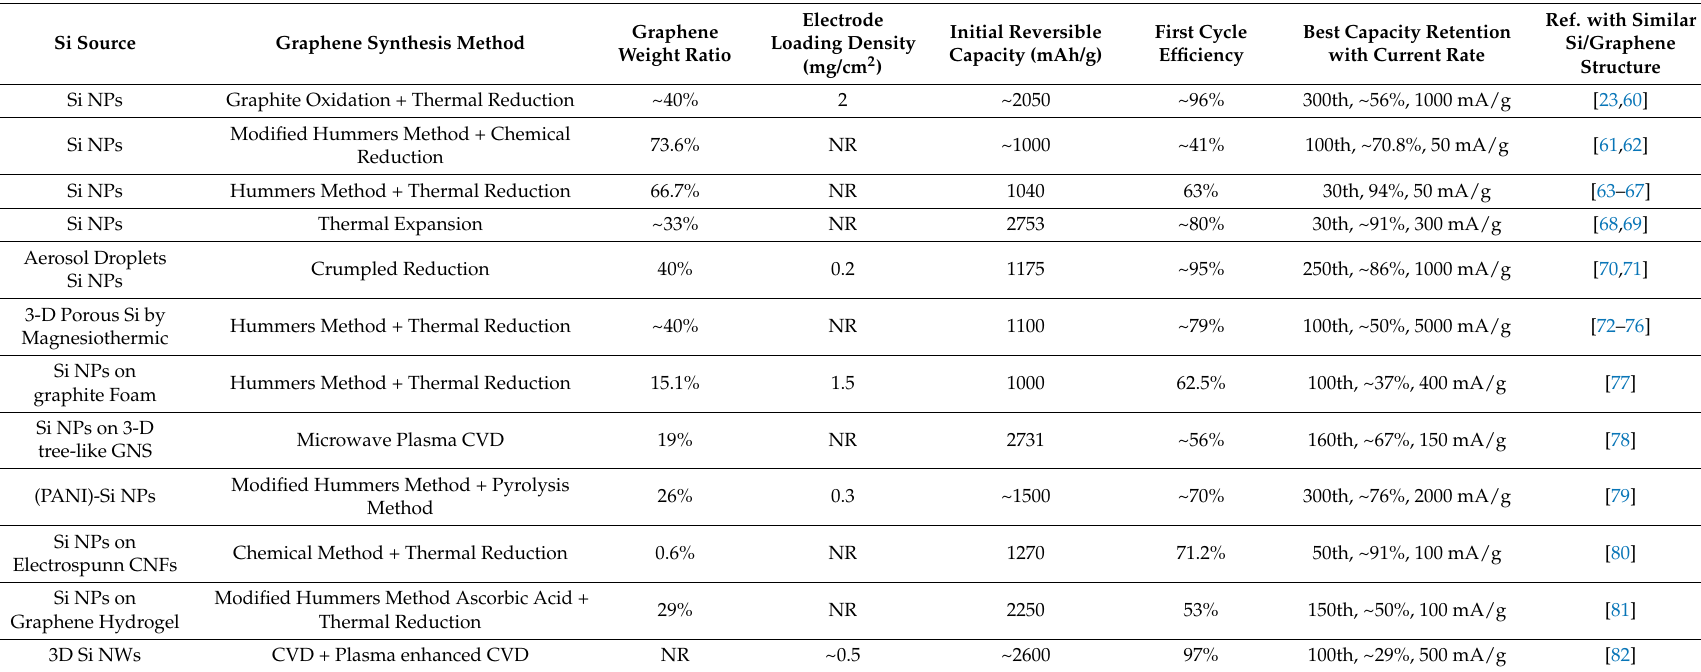
Table 3. A summary of studies on Si/Graphene nanocomposites